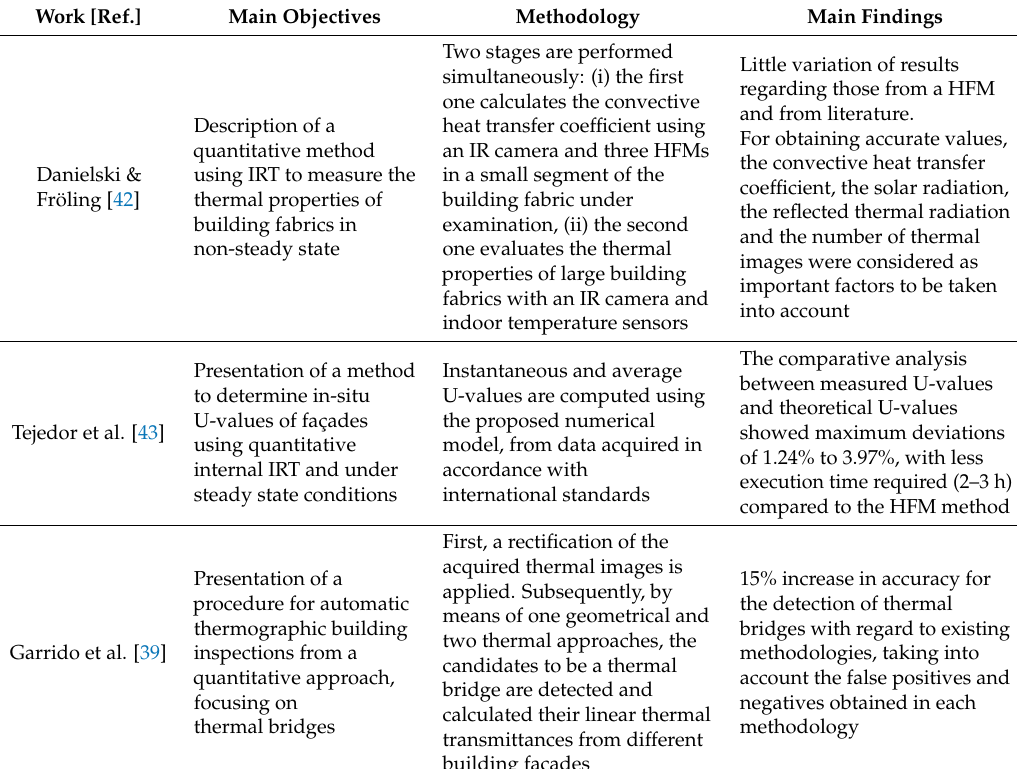
Table 1. Review of IRT studies in